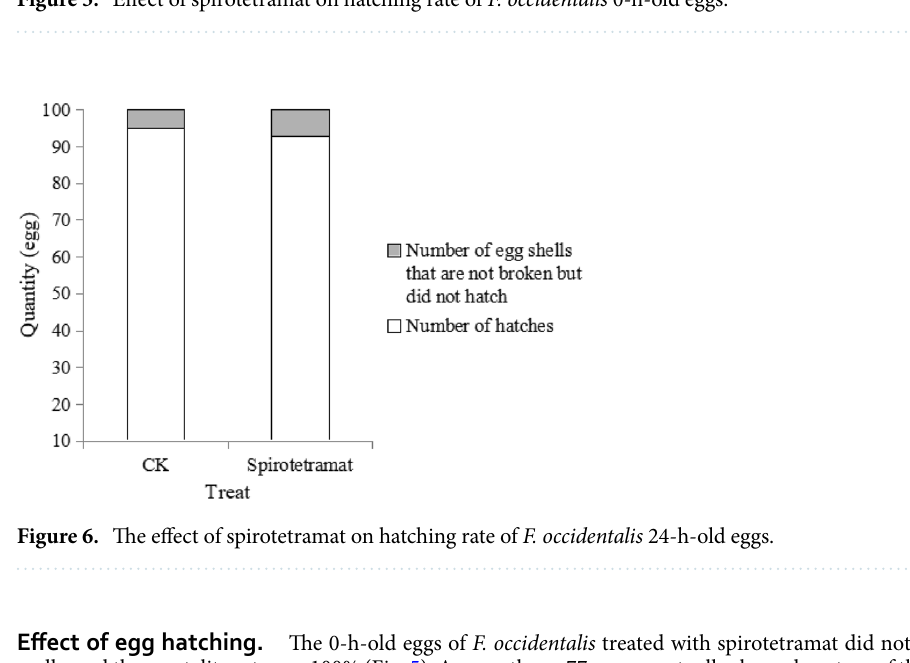
Figure 5. Effect of spirotetramat on hatching rate of F. occidentalis 0-h-old eggs.